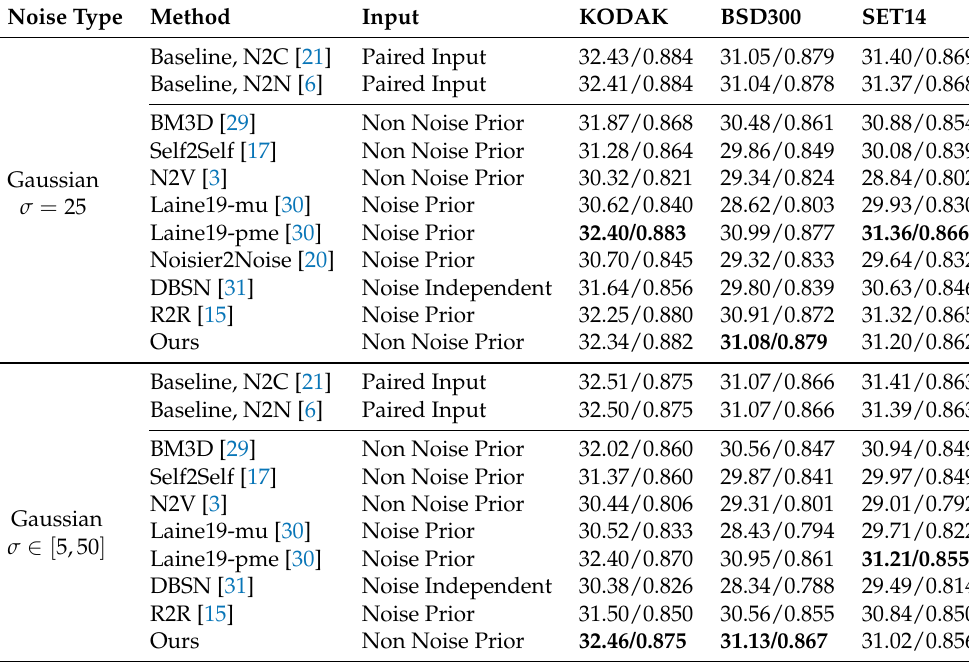
Table 1. Quantitative denoising results on synthetic datasets in sRGB space. The highest PSNR(dB)/SSIM among unsupervised denoising methods is highlighted in